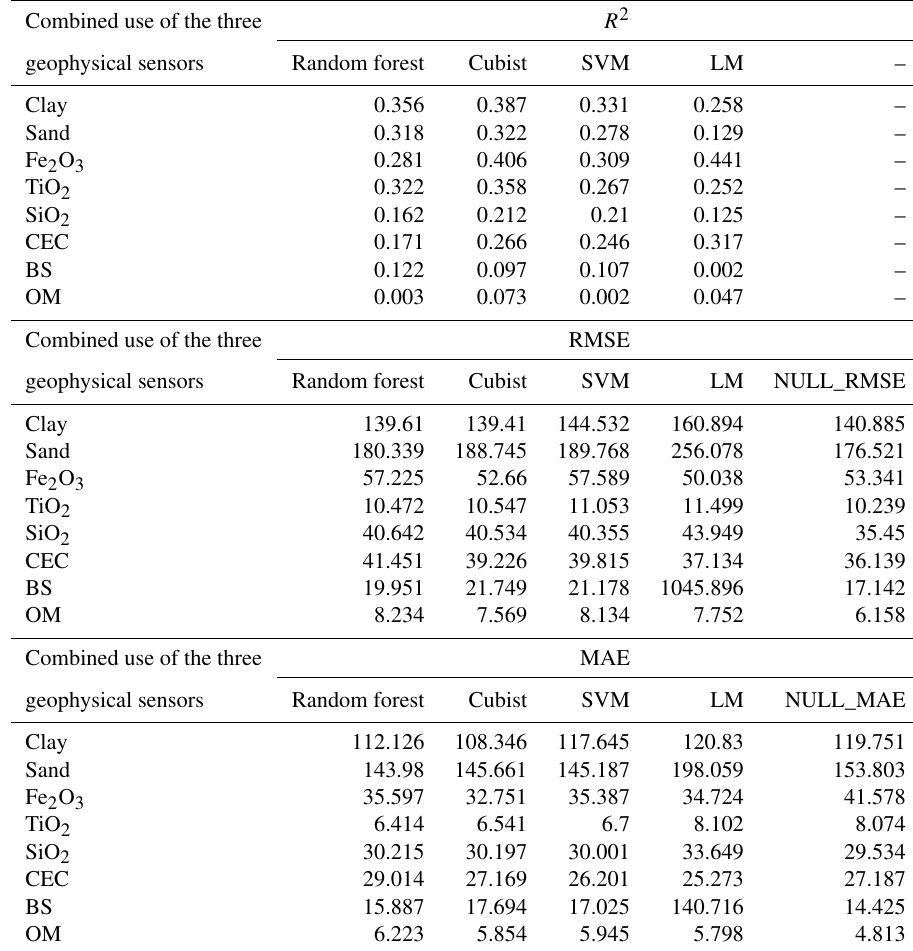
Table 6. Model performance for all combined use of geophysical sensors, for all soil attributes, based on R 2 , RMSE, MAE, and